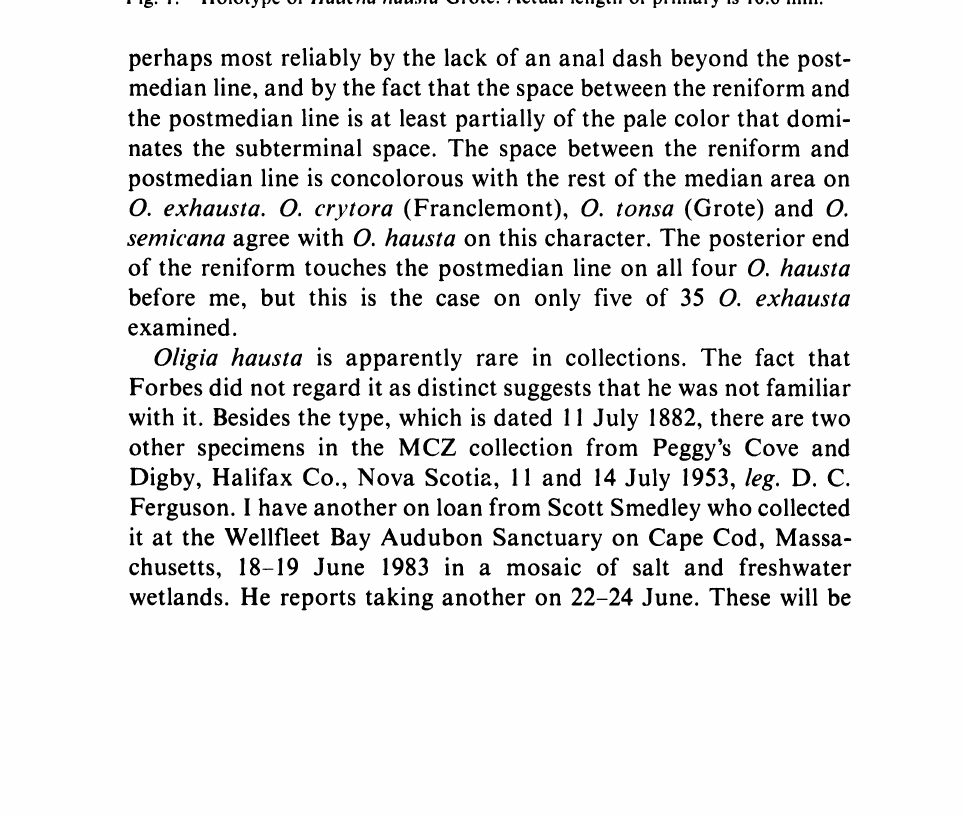
Fig. I. Holotype of Hadena hausta Grote. Actual length of primary is 10.6